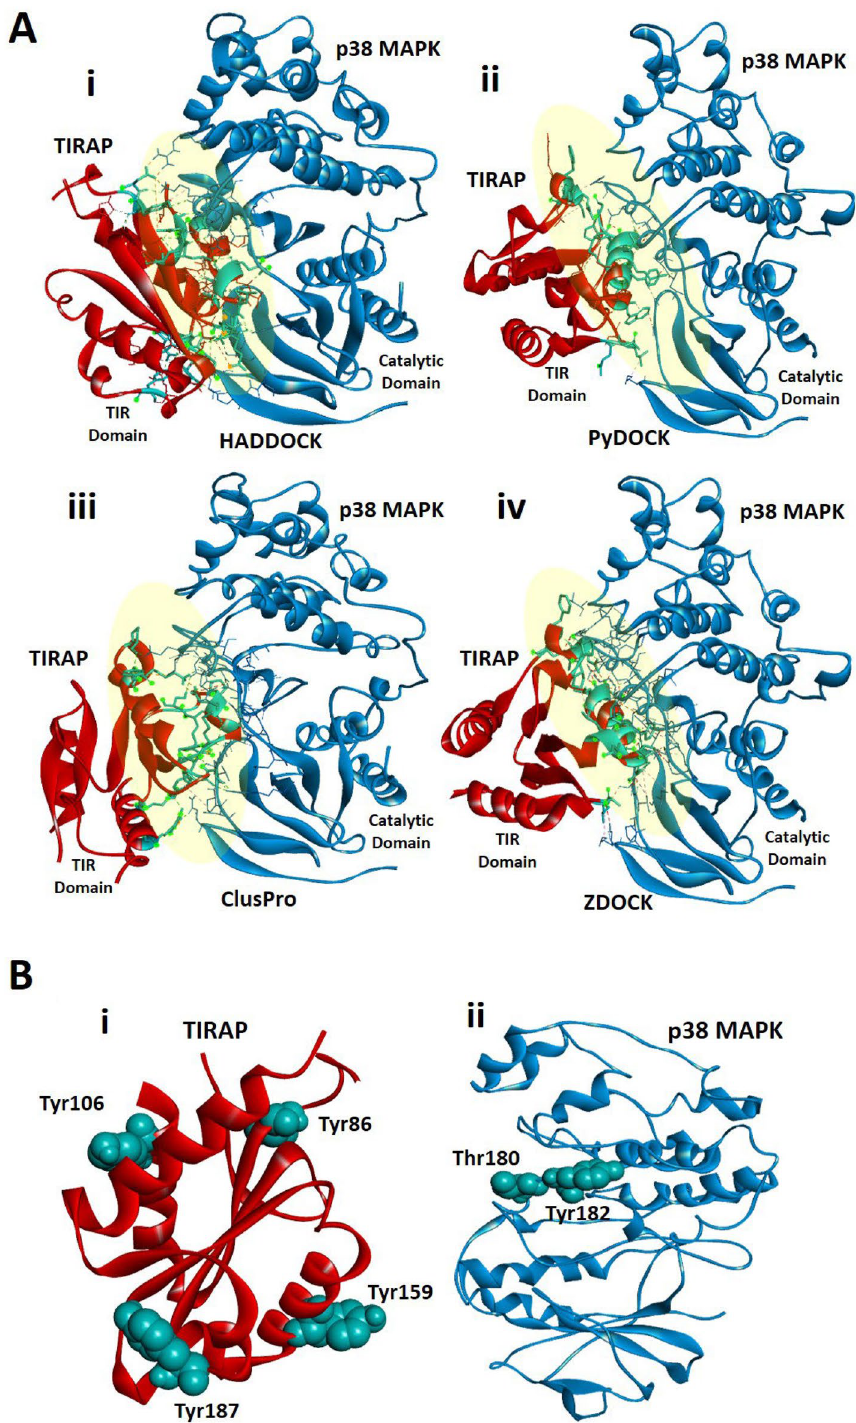
Figure 1. The protein–protein interaction of TIRAP and p38 MAPK. ( A ) The molecular docking complexes of TIRAP TIR domain (red) and full-length p38α MAPK protein (blue) as obtained from (i) HADDOCK 2.4 (ii) pyDockWEB (iii) ClusPro and (iv) ZDOCK 3.0.2. ( B ) Illustration of crucial tyrosine residues of (i) TIRAP TIR domain (red) Y86, Y106, Y159, and Y187, and (ii) p38 MAPK (blue) active site Y182 residue in space- filling cpk (Corey-Pauling-Koltun), respectively. The images were prepared using a Discovery studio Visualizer